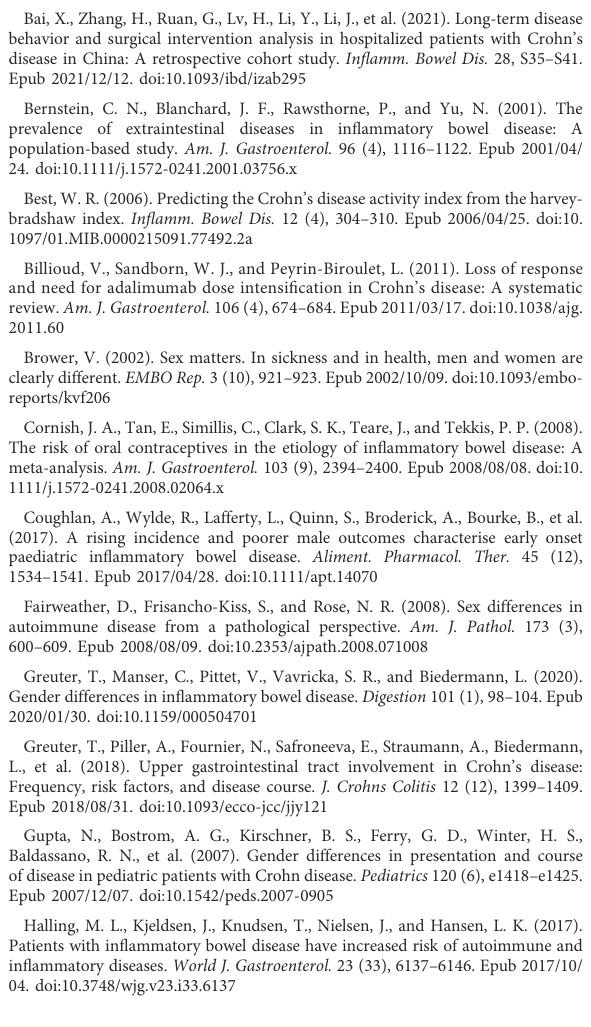
SUPPLEMENTARY FIGURE S1 Comparison of partial clinical characteristics between female and